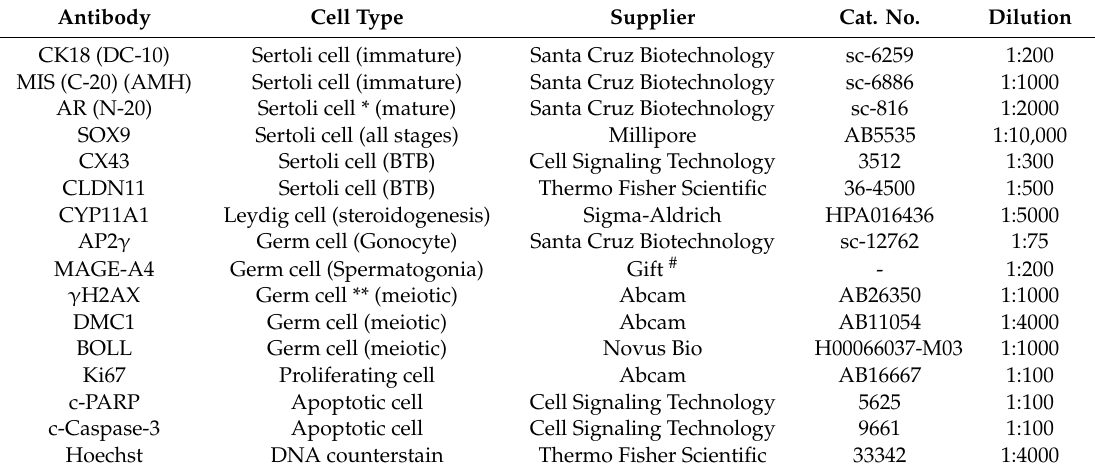
Table 1. Antibodies used for